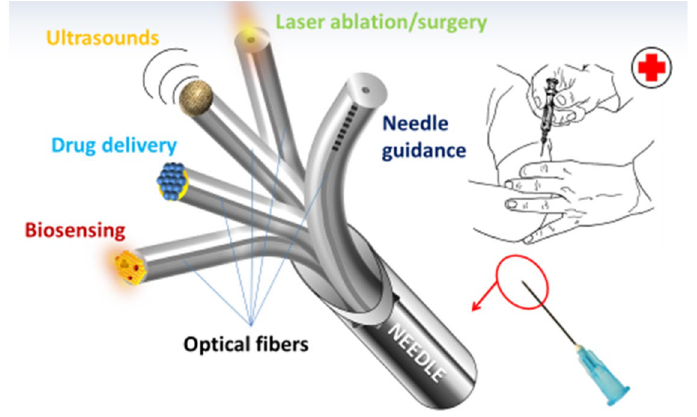
Figure 4. Sketch illustrating the idea of “the hospital in the